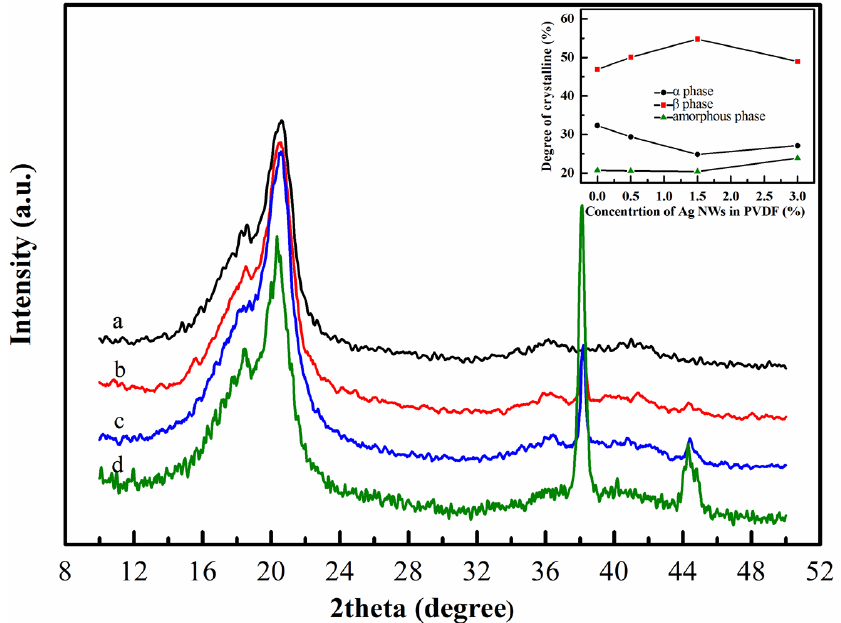
Figure 2. XRD patterns of the electrospun nanofiber webs with the concentration of Ag NWs doped: ( a ) 0. ( b ) 0.5 wt%. ( c ) 1.5 wt%. ( d ) 3.0 wt%.